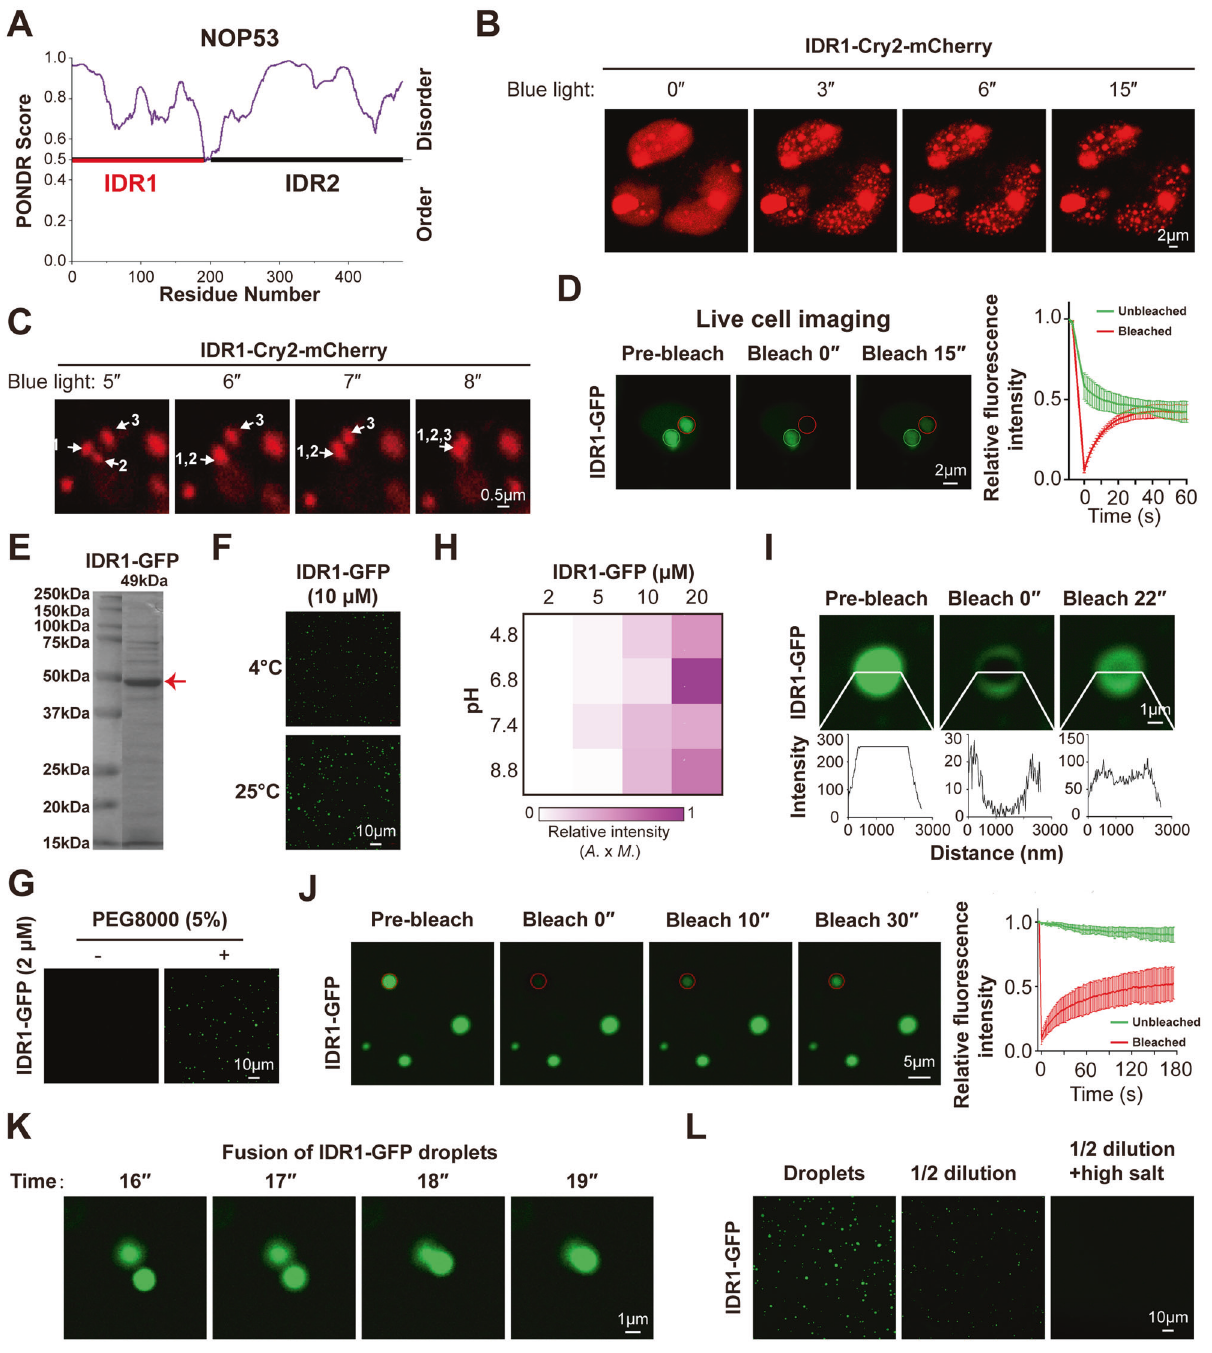
Fig. 3 IDR1 drives the LLPS of NOP53. A The disordered region of NOP53 was analyzed with PONDR (www.pondr.com). B IDR1-Cry2-mCherry was expressed in cells, which were stimulated with blue light to induce condensation. C IDR1-Cry2-mCherry droplets fused to form a larger droplet upon stimulation with blue light. D FRAP of IDR1-GFP puncta in HEK293T cells. E Coomassie staining of puri fi ed NOP53-IDR1-GFP protein. F NOP53-IDR1-GFP protein formed droplets at different temperatures. Ten micromolar protein was used. G PEG-8000 enhanced the formation of NOP53-IDR1-GFP droplets. Two micromolar protein was used. H The impact of protein concentration and pH on the formation of NOP53-IDR1-GFP droplets. The fl uorescence intensity of droplets is presented as the mean intensity × area. I , J FRAP of IDR1-GFP droplets in vitro. K Two in vitro-formed IDR1-GFP droplets fused to form a larger droplet. L IDR1-GFP droplets were disrupted by dilution and increasing NaCl concentrations. Droplets formed in buffer containing 10 μ M IDR1-GFP and 150 mM NaCl at pH 7.4; high salt, 500 mM NaCl. For ( D and J ), n = 3 punctum analyzed in 3 independent experiments. Data are mean ± in NOP53 protein. By removing all M-R/R motifs, NOP53 was also undergo LLPS via homotypic interactions between its acidic- presented only in nucleoplasm, but still formed LLPS condensates, and basic-tracts within its IDR [32]. In this study, we showed that indicating that NOP53 underwent LLPS independent of nucleoli, NOP53 resided predominantly in the GC and was co-localized with instead of just being recruited to nucleoli by NPM1. NPM1, which was ascribed to the presence of dozens of M-R motifs